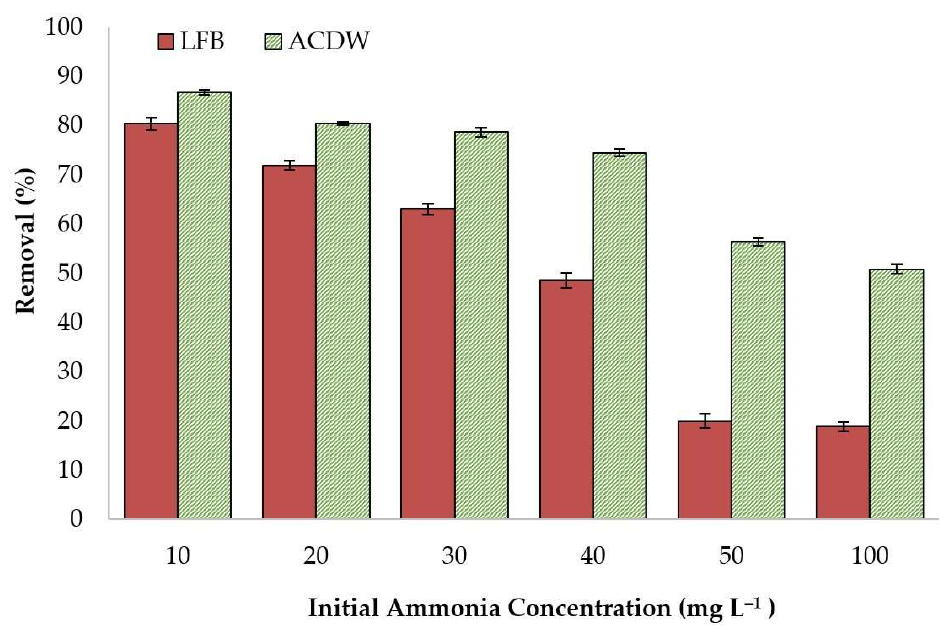
Figure 7. Influence of initial ammonia concentration on the treatment of ammonia using whole biomass (ACDW) and lipid-free biomass (LFB) of Arthrospira platensis